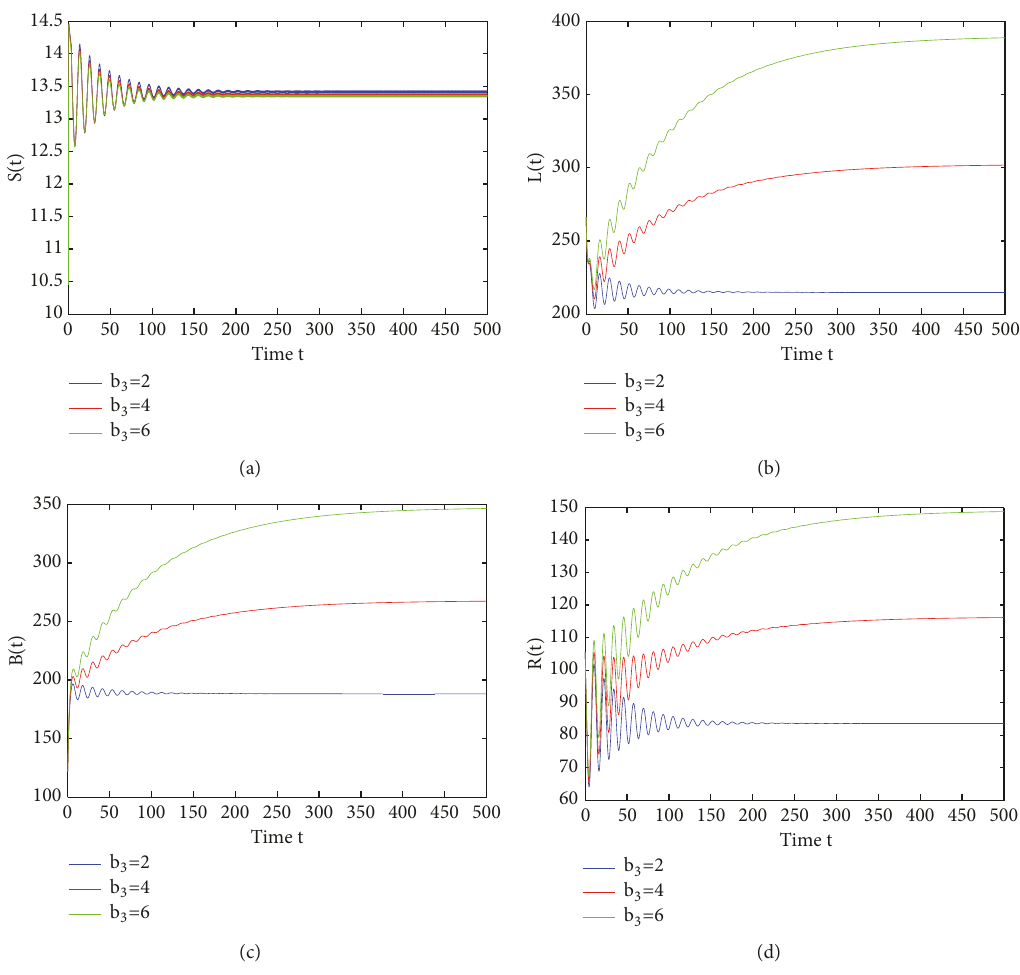
Figure 13: Time plots of 𝑆 , 𝐿 , 𝐵 , and 𝑅 for different 𝑏 3 at 𝜏 = 3.2575 . Rest of the parameters are taken as given in the